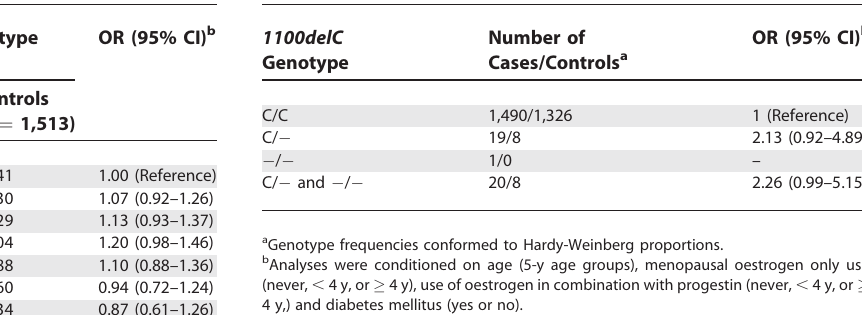
Table 4. Common Haplotypes Reconstructed Using Six tagSNP in CHEK2 in Relation to Breast Cancer Risk